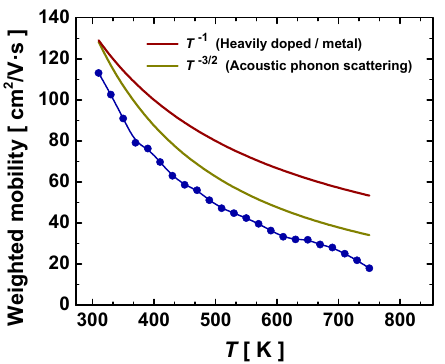
Figure 7. Calculated weighted mobility of the Gd-filled skutterudite obtained under high-pressure conditions at 3.5 GPa (dark-blue symbols). The brown and dark-yellow lines exhibit trends associated with different behaviors, heavily doped and acoustic-phonon scattering, respectively.